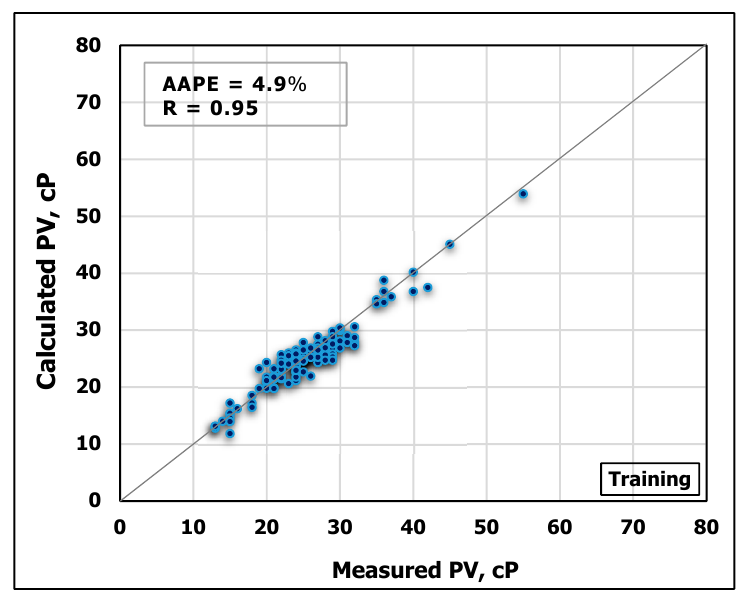
Figure 7. Measured PV vs. predicted PV from the ANN model for the training process. Sensors 2020 , 20 , x